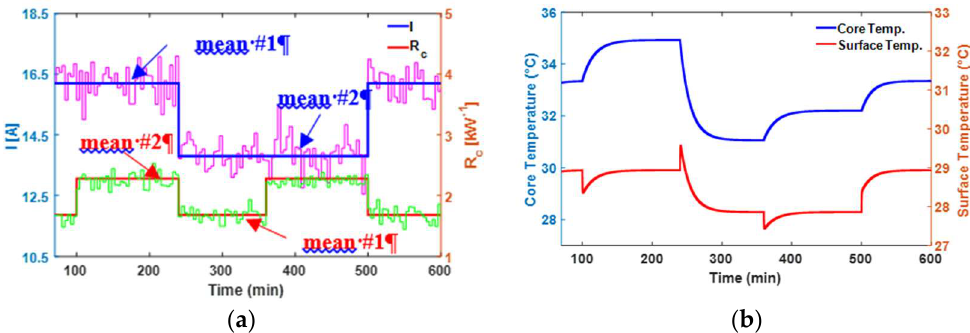
Figure 2. Profiles of faults ( a ) and the corresponding noise-free temperature ( b ). Note that the purple and green lines in ( a ) represent the perturbations around the mean values of possible faults, and noise free measurements of temperatures are used in ( b ) for clarity.